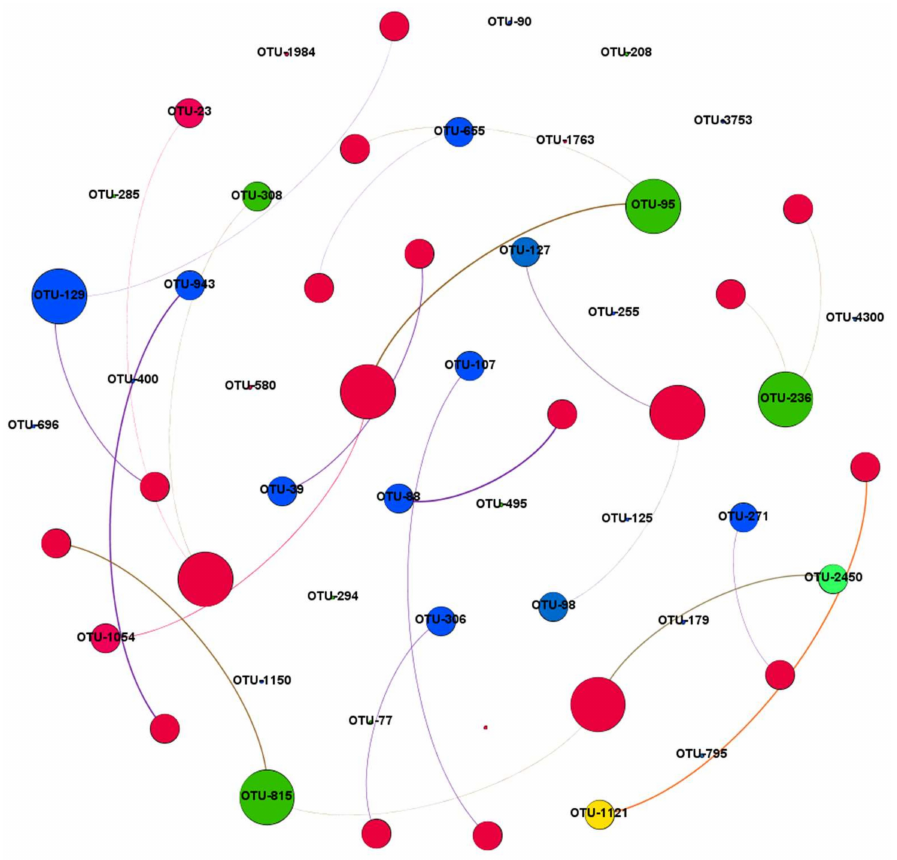
Figure 4. The co-occurrence network of the soil bacterial classes as affected by nitrogen (N) fertilizer treatments. Each circle represents an OTU, which are colored by modules. The size of each circle node represents its degree. The width of each connecting line represents its weight, and the colors of the edges are consistent with the colors of the nodes (circle) to which they are